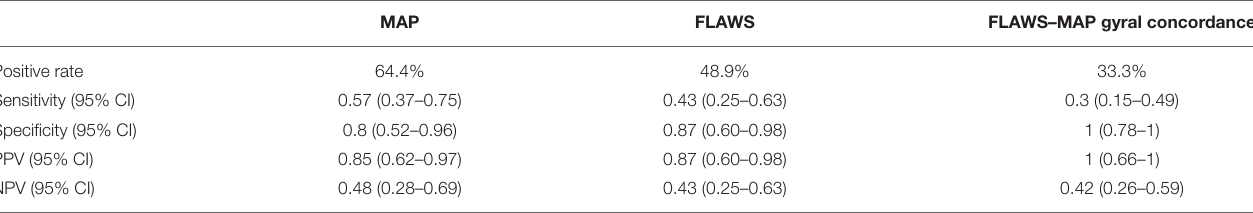
TABLE 2 | Positive rate, sensitivity, specificity, PPV, and NPV in MAP, FLAWS, and FLAWS–MAP gyral concordance. MAP FLAWS